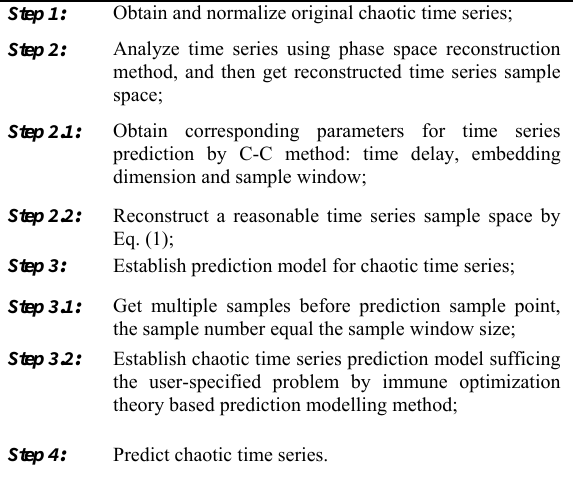
Algorithm 3. The algorithm of